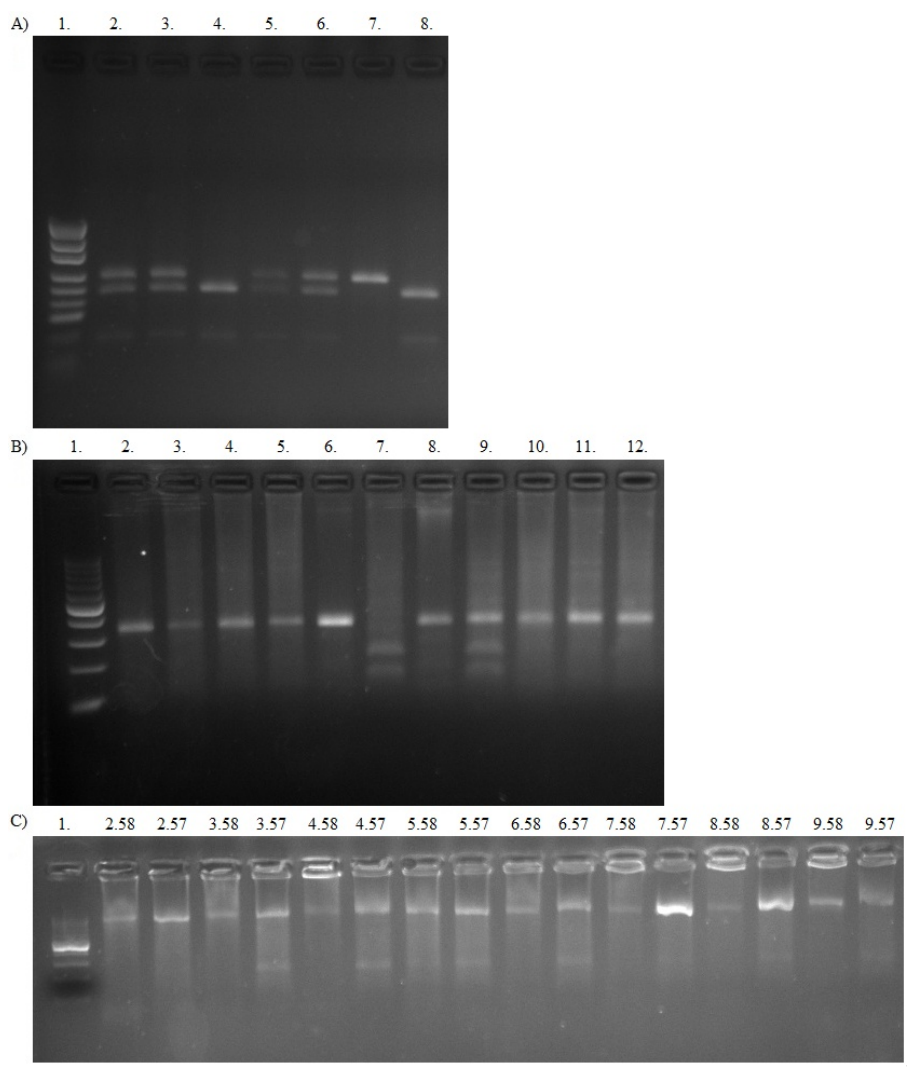
Figure 2. Electropherograms of studied polymorphisms obtained by PCR-RFLP method. ( A ) ABCB1 3435C > T SNP, Lane 1—Ladder (consists of 34, 67, 110, 147, 190, 242, 331, 404, 489 bp bands); Lanes 4 and 8 contain 172 bp and 60 bp bands (CC genotype); Lanes 2, 3, 5 and 6 contain 238 bp, 172 bp and 60 bp (CT genotype); Lane 7 contains 238 bp (TT genotype); ( B ) CYP1A1 6235T > C variant, Lane 1—Ladder (100 bp); Lanes 2–6, 8 and 10–12 contain 340 bp (wild type allele); Lane 9 shows 340